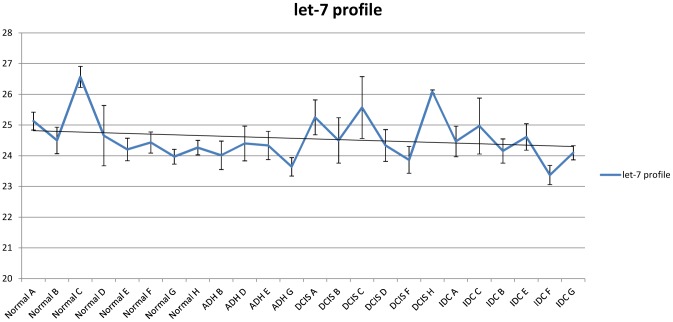
qRT-PCR results displaying the raw Ct values of let-7a across all samples and stages.The profile shows that let-7a expression was relatively consistent among different components and patients. The error bars indicate that the standard error of mean (SEM) is n = 4.